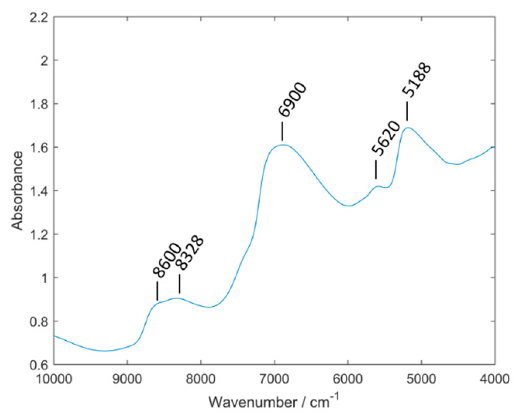
Figure 4. Averaged spectra set of elderberry samples measured with Büchi NIRFlex N-500.